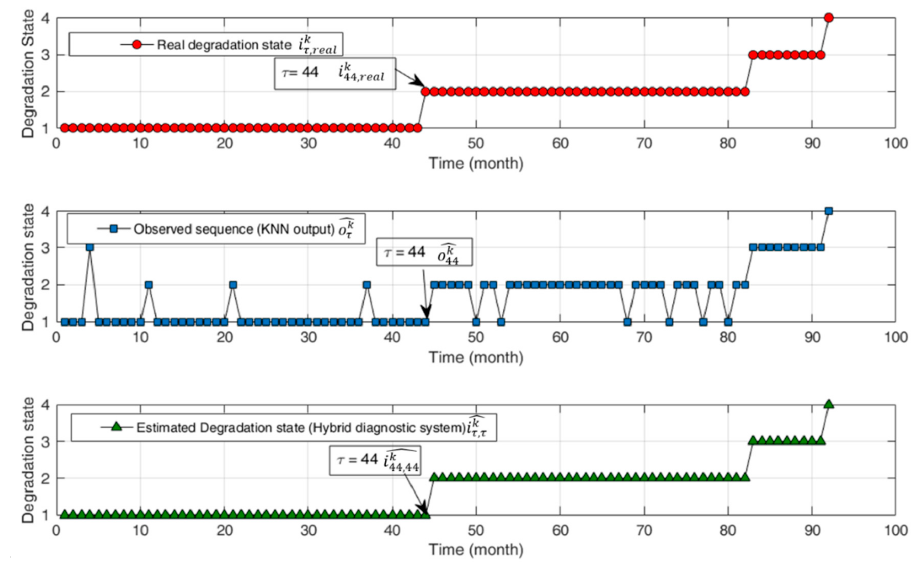
Figure 7. Typical case in which degradation state errors occur ( Top : real degradation states; middle : degradation states estimated by the KNN classifier; bottom : degradation states estimated by the hybrid diagnostic system).